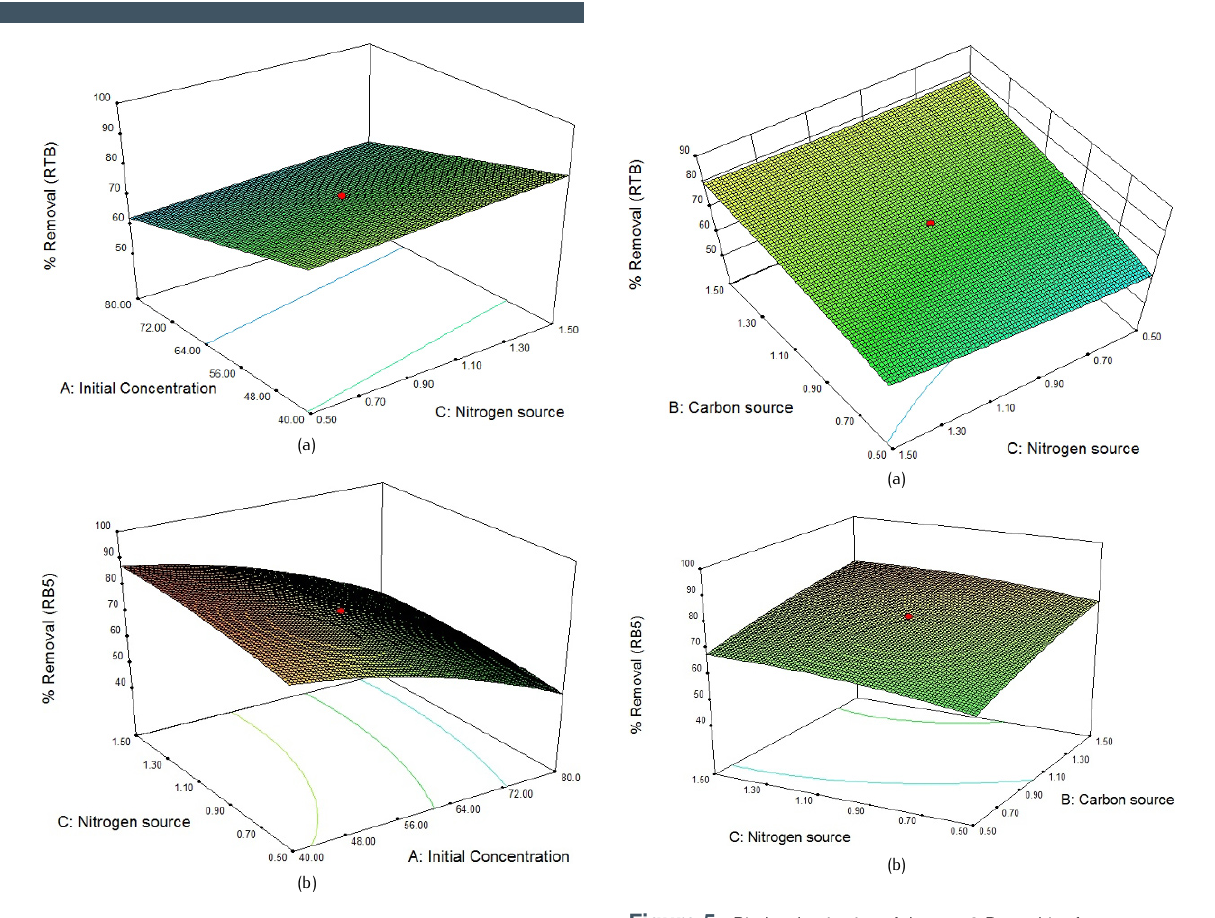
Figure 4. Biodecolourization of dyes on 3-D graphics for response surface optimization Initial dye concentration versus Nitro- gen source (a) RTB and (b) RB5.